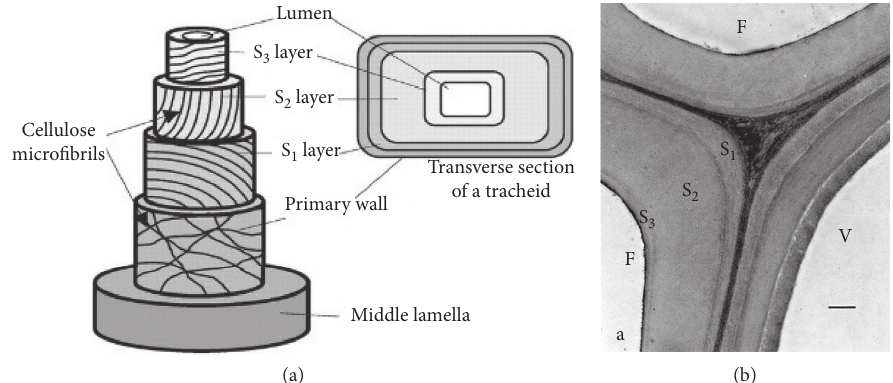
Figure 4: (a) Schematic of a single fibre structure [34] and (b) TEM micrography of the cell wall layer showing the middle lamella (darkest shaded colour between fibres), S1, S2, and S3 [35].